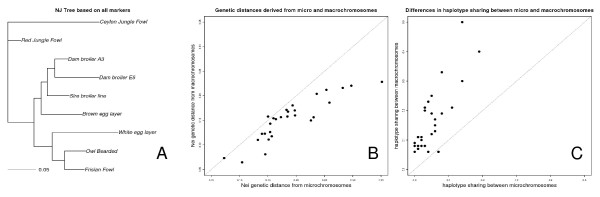
A: Neighbor Joining tree based on genetic distances between population derived from all markers considered in this study. B:Difference between haplotype sharing based on microchromosomal (horizontal axis) versus sharing based on macrochromosomal (vertical axis) haplotypes. Sharing was calculated as the average over a sliding window of window size of ~30 kb. Haplotype sharing is almost consistently lower in microchromosomes. C: Difference in genetic distances based on microchromosomal (horizontal axis) and macrochromosomal (vertical axis) genotypes. Genetic distances are almost consistently higher in microchromosomes.